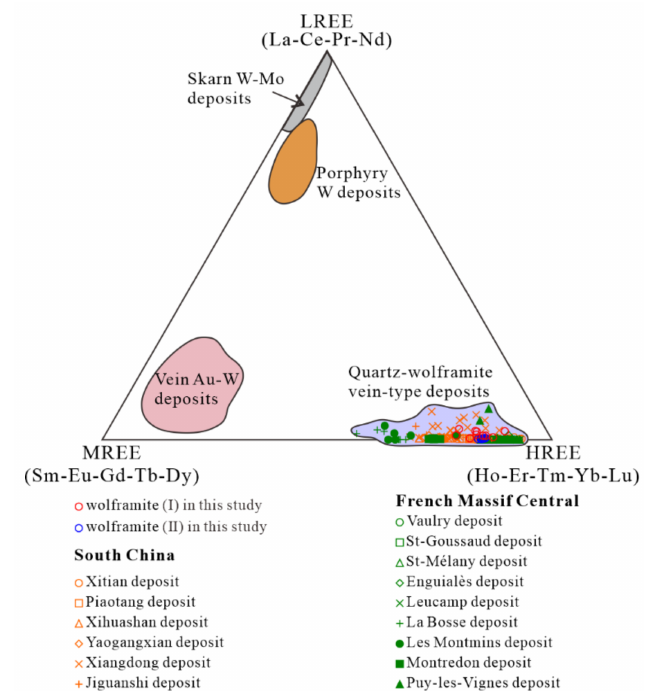
Figure 17. A LREE–MREE–HREE diagram showing the composition of different types of W deposits in the world (modified after [110]). The data of wolframite from quartz–wolframite vein-type deposits are listed in Supplementary Material Table